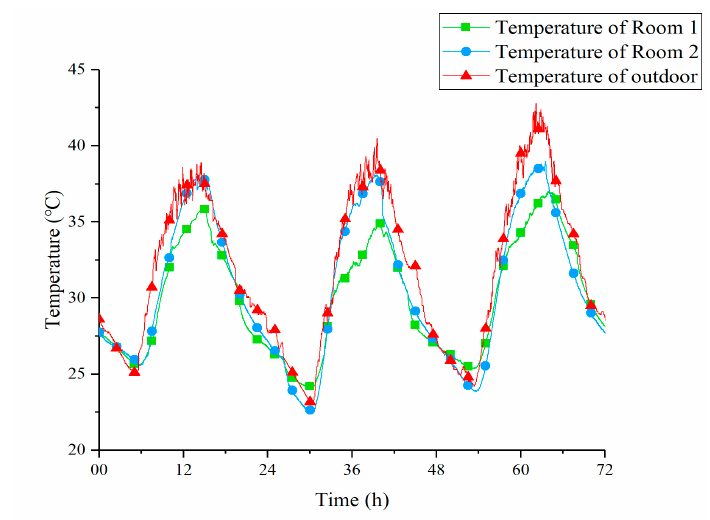
Figure 8. Temperature curves of Room 1, Room 2, and outdoor under Strategy 1. Table 7. Peak temperature comparison under Strategy 1.